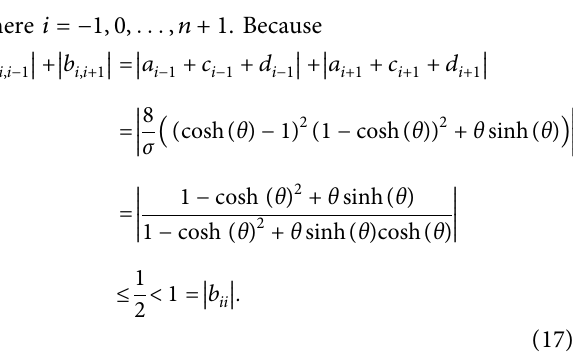
( x ) 􏽮 􏽯 n + 1 of the exponential spline function j j �− 1